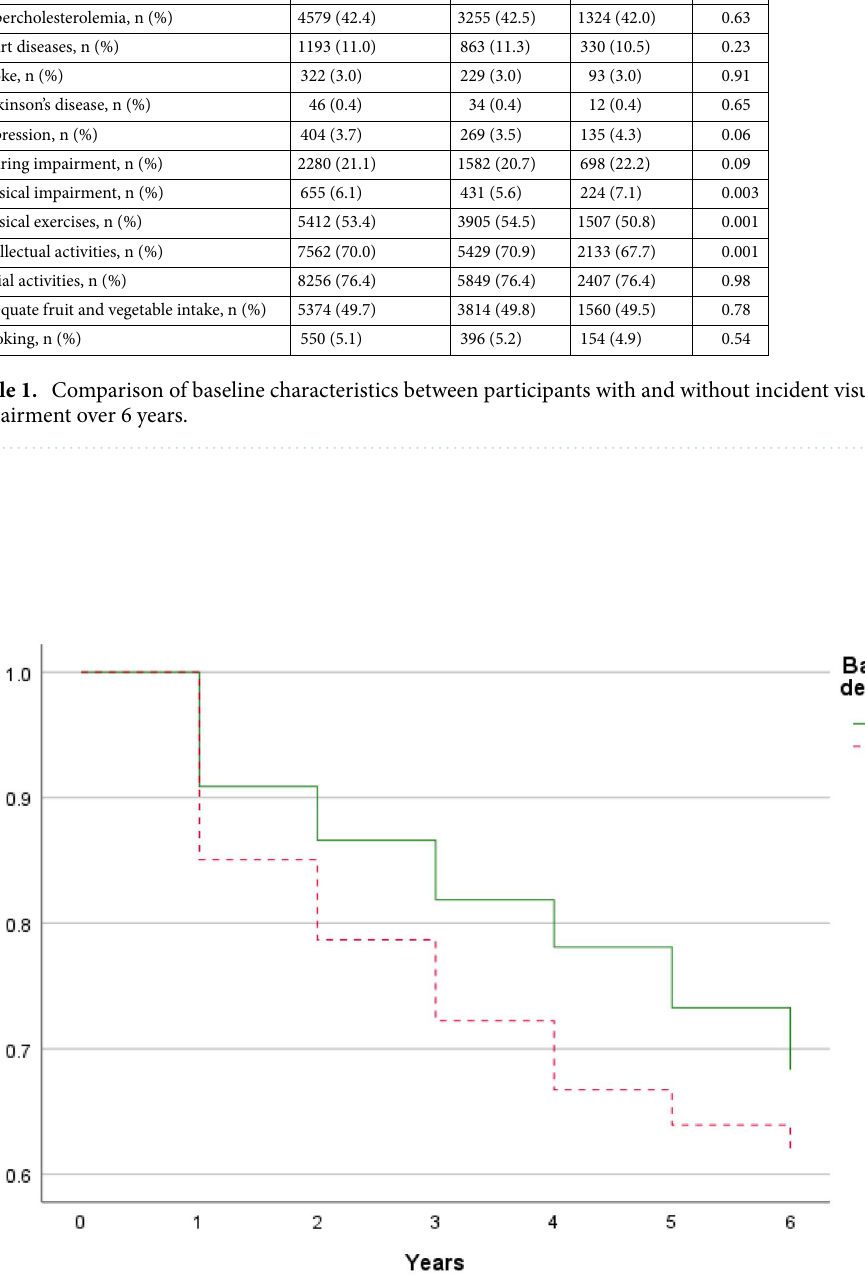
Figure 2. Differences between dementia and dementia-free groups in terms of the distribution of time till visual impairment (the event)